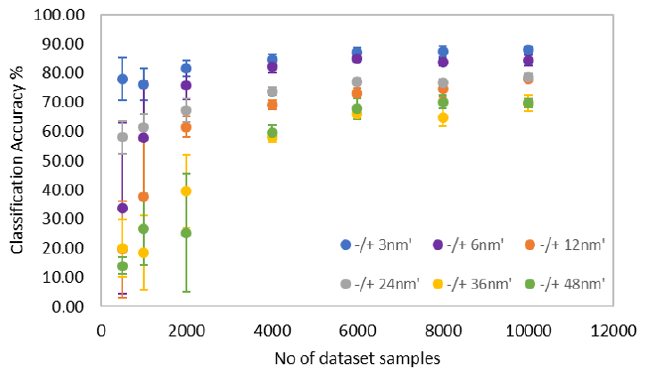
Figure 7. Classification accuracy of the VGG-type DNN classifier used in the experiment for increasing the number of available samples in the training dataset.